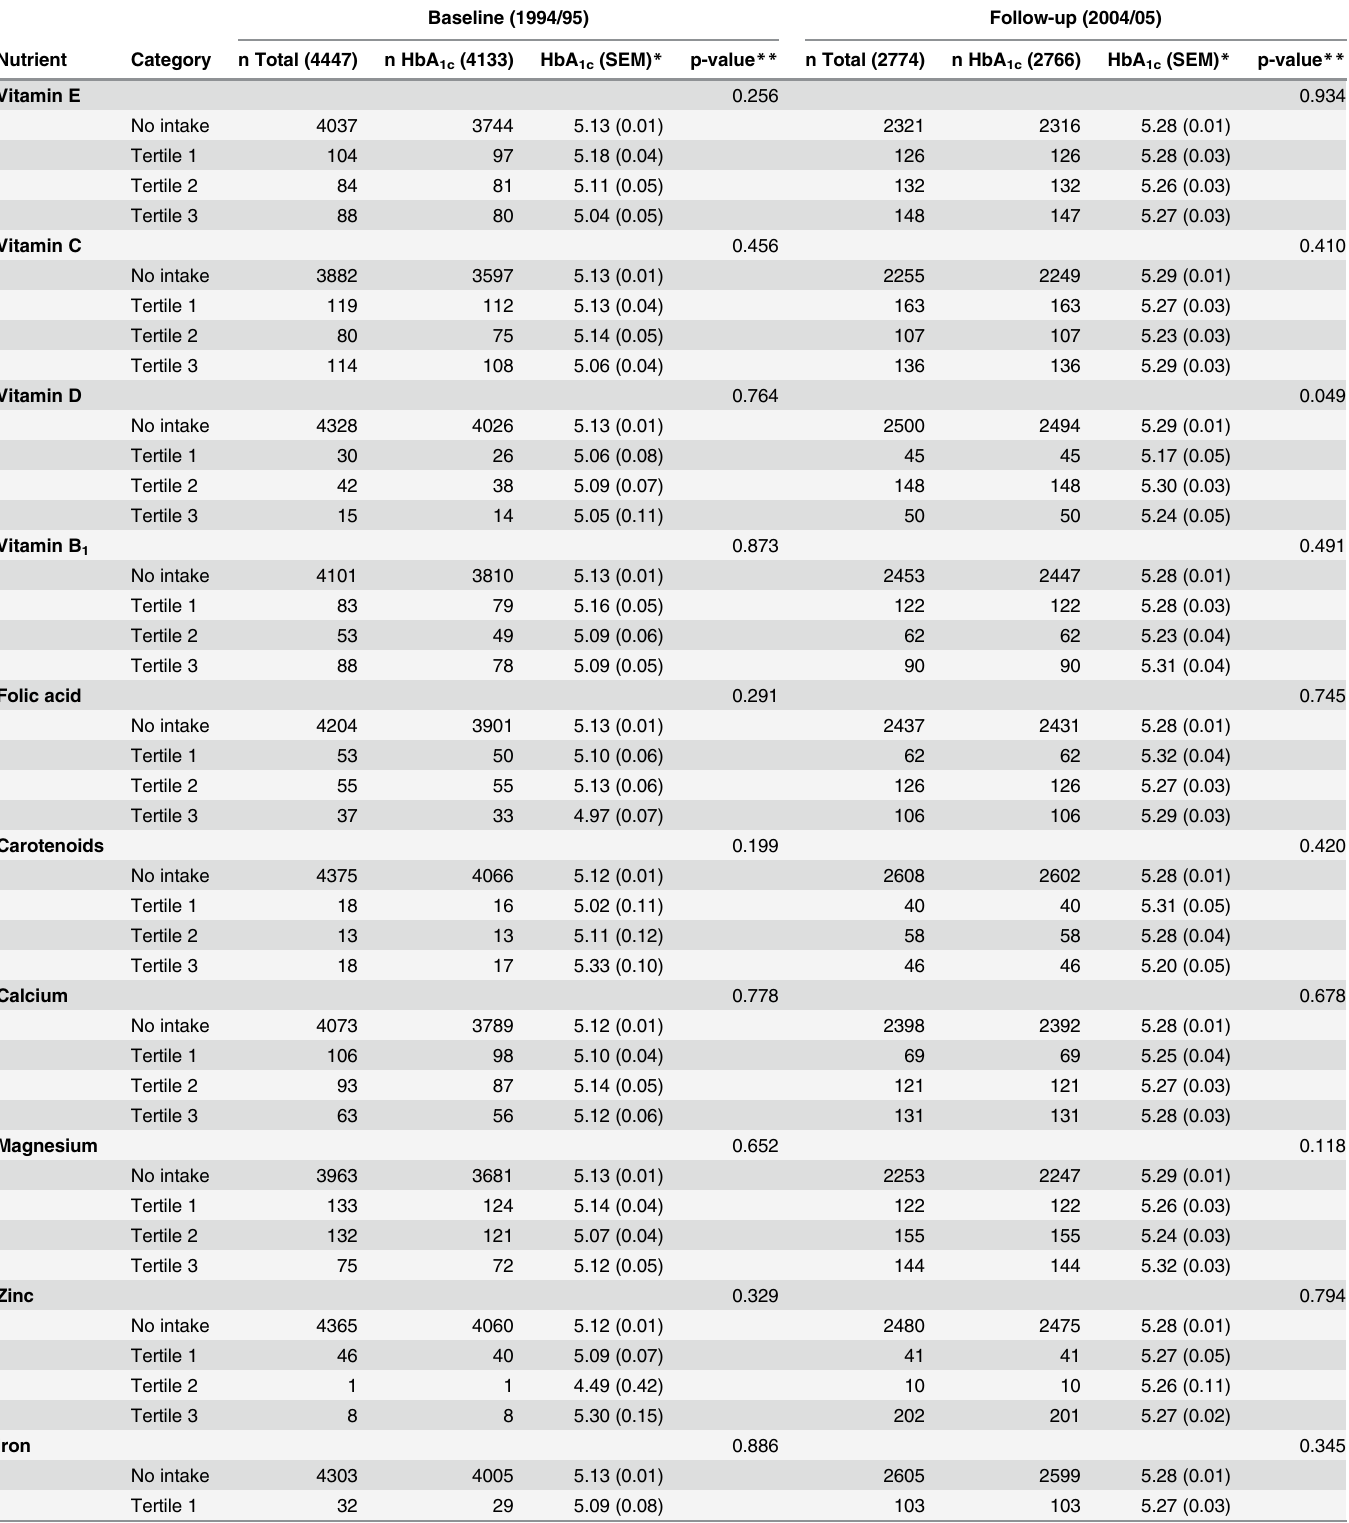
Table 2. Adjusted mean levels of HbA 1c by categories of exposure variables at baseline (1994/95) and follow-up